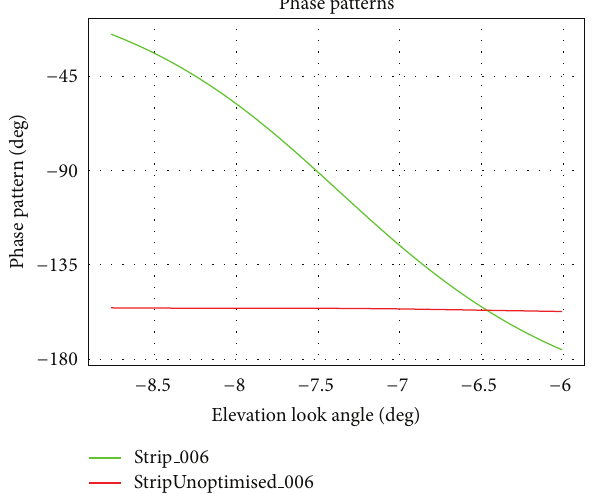
Figure 1: Phase patterns of a tapered (green) and an untapered (red) beam.